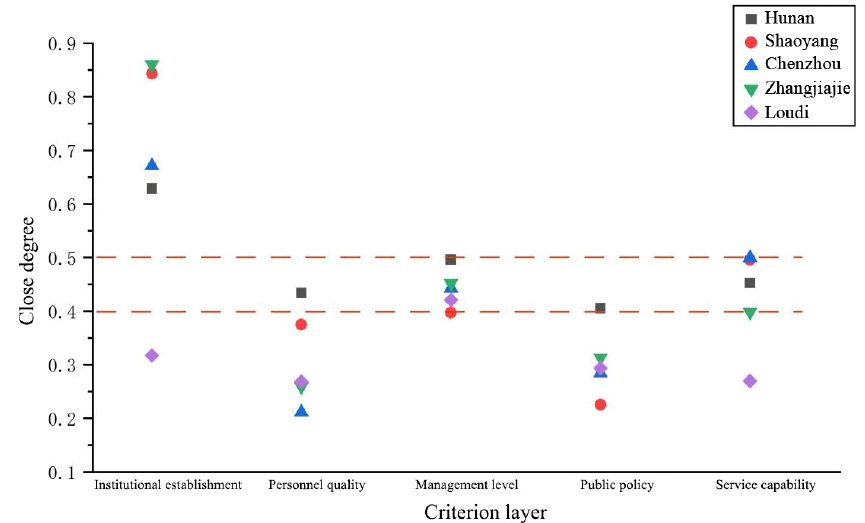
Figure 6. The third level of close degree of criterion layer of grassroots water service in Hunan Prov- ince. nan